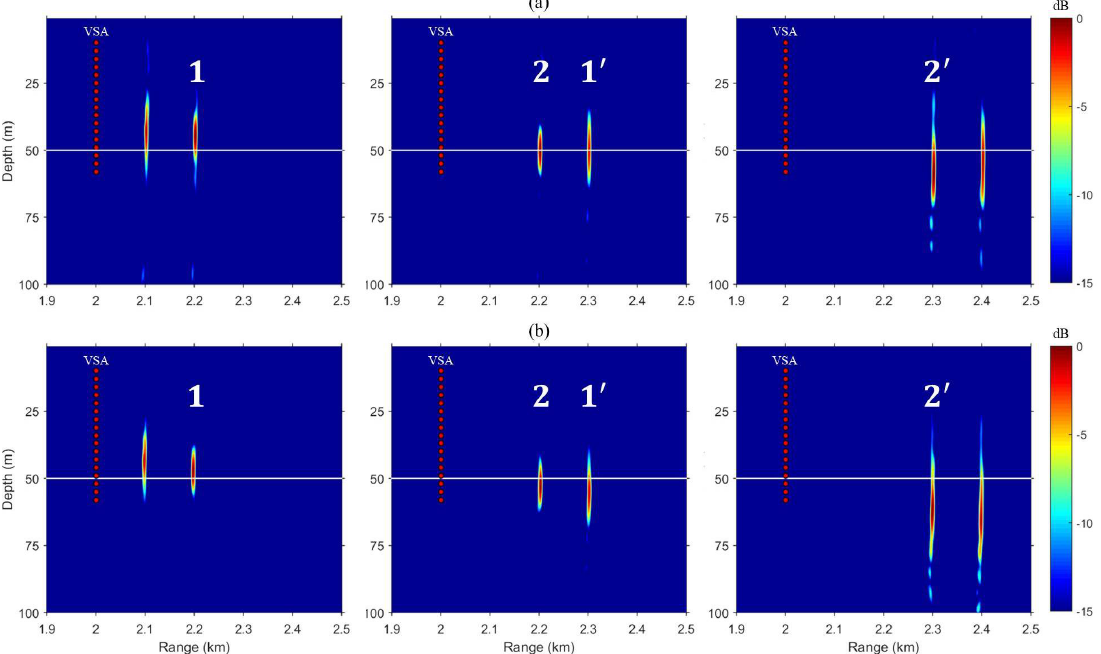
Figure 4. (Color online) Simulated VSA-based multiple TR focusing using superposition method. Each panel represents a backpropagated field corresponding to a different single snapshot time. ( a ) For isovelocity SSP; ( b ) For downward-refracting SSP. The numbers here correspond one-to-one with the time series in Figure